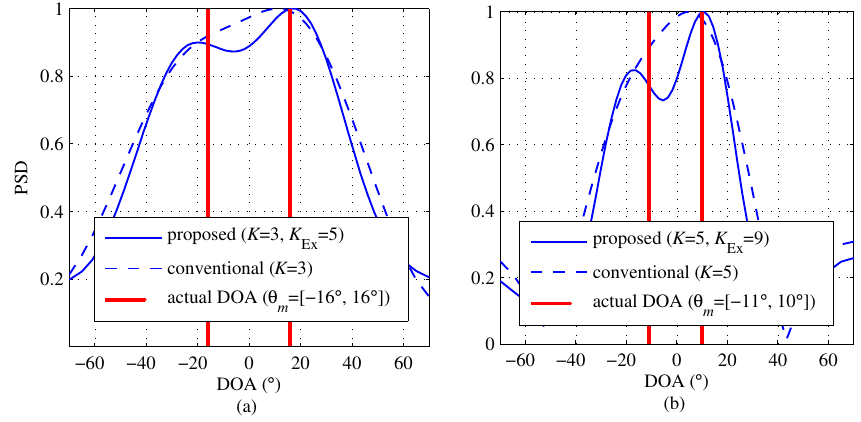
Figure 6. Comparison of the resolution of proposed ( U q ) and conventional ( Y q ) algorithms with M = 2, ( a ) K = 3 and [ θ 1 , θ 2 ] = [ − 16 ◦ , 16 ◦ ]; ( b ) K = 5 and [ θ 1 , θ 2 ] = [ − 11 ◦ , 10 ◦